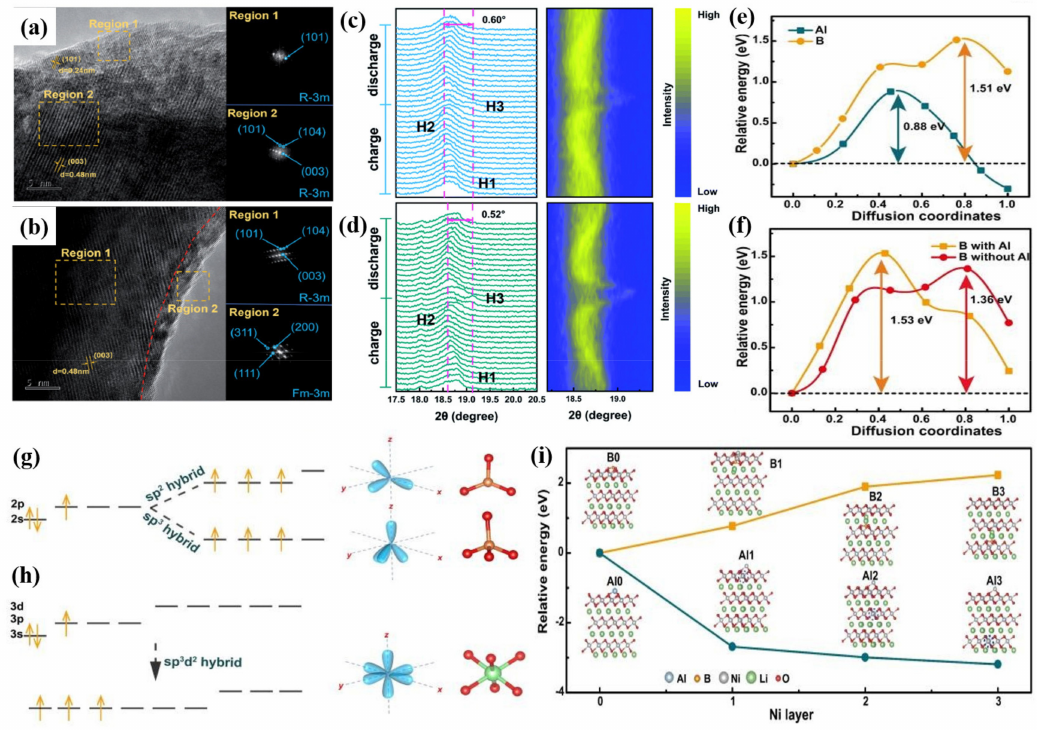
Figure 7. HRTEM images and corresponding FFT patterns for ( a ) NCM and ( b ) 0.5Ti@0.5F–NCM. In situ XRD tests of ( c ) NCM and ( d ) 0.5Ti@0.5F–NCM, including the detailed diffraction patterns and the corresponding contour plots. Reproduced with permission from ref. [77]. Copyright 2021 The Royal Society of Chemistry. ( e ) Al and B migration energy barrier from the first layer to the second layer. ( f ) B migration energy barrier from the surface to the first layer with Al and without Al. Orbit hybridization of ( g ) B and ( h ) Al. ( i ) The corresponding energy of different structures with doping Al and B to different layers. Reproduced with permission from ref. [78]. Copyright 2022 John Wiley and